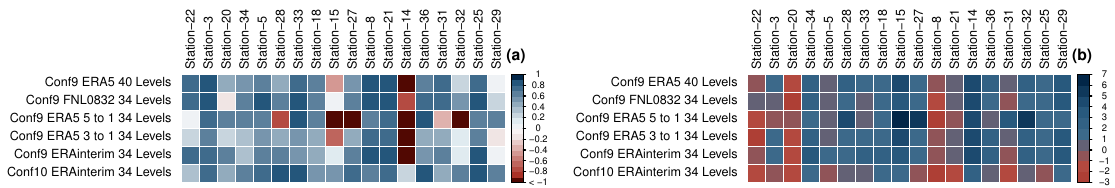
Figure 8. Matrix of statistics for precipitation for different forcing data: ( a ) NSE, and ( b ) PBIAS.